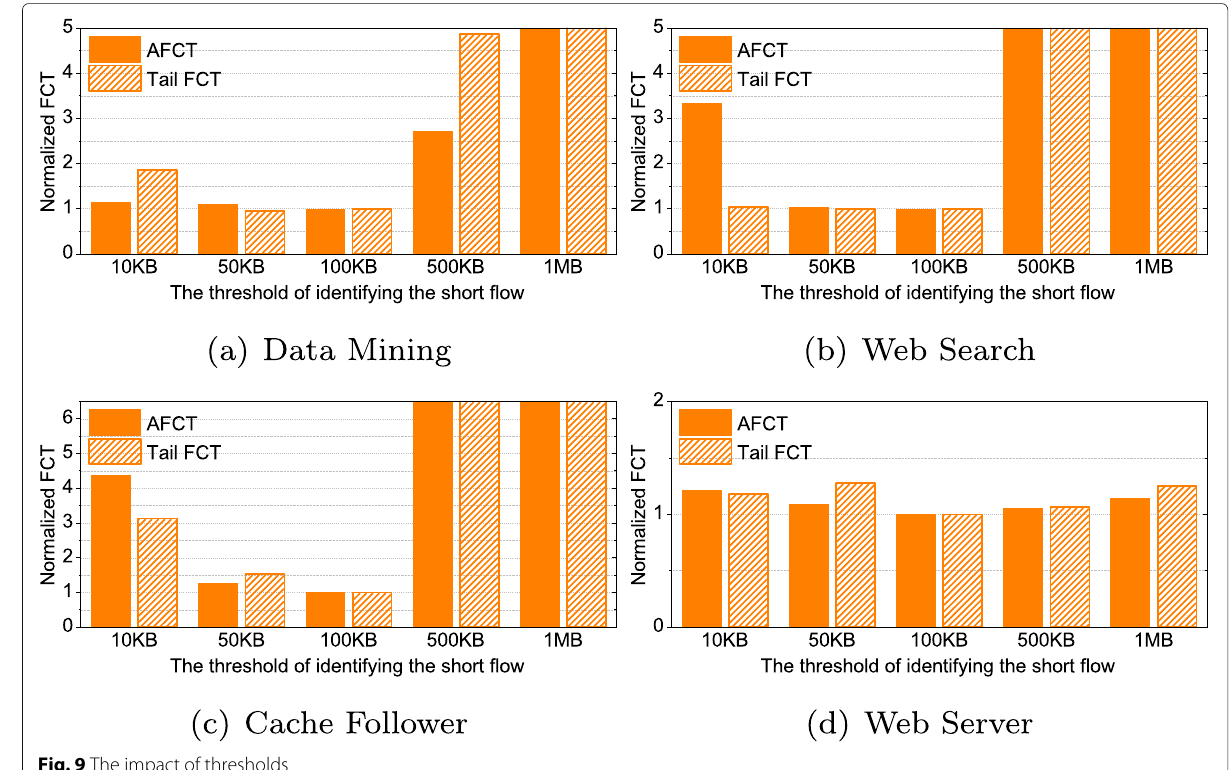
Fig. 9 The impact of thresholds